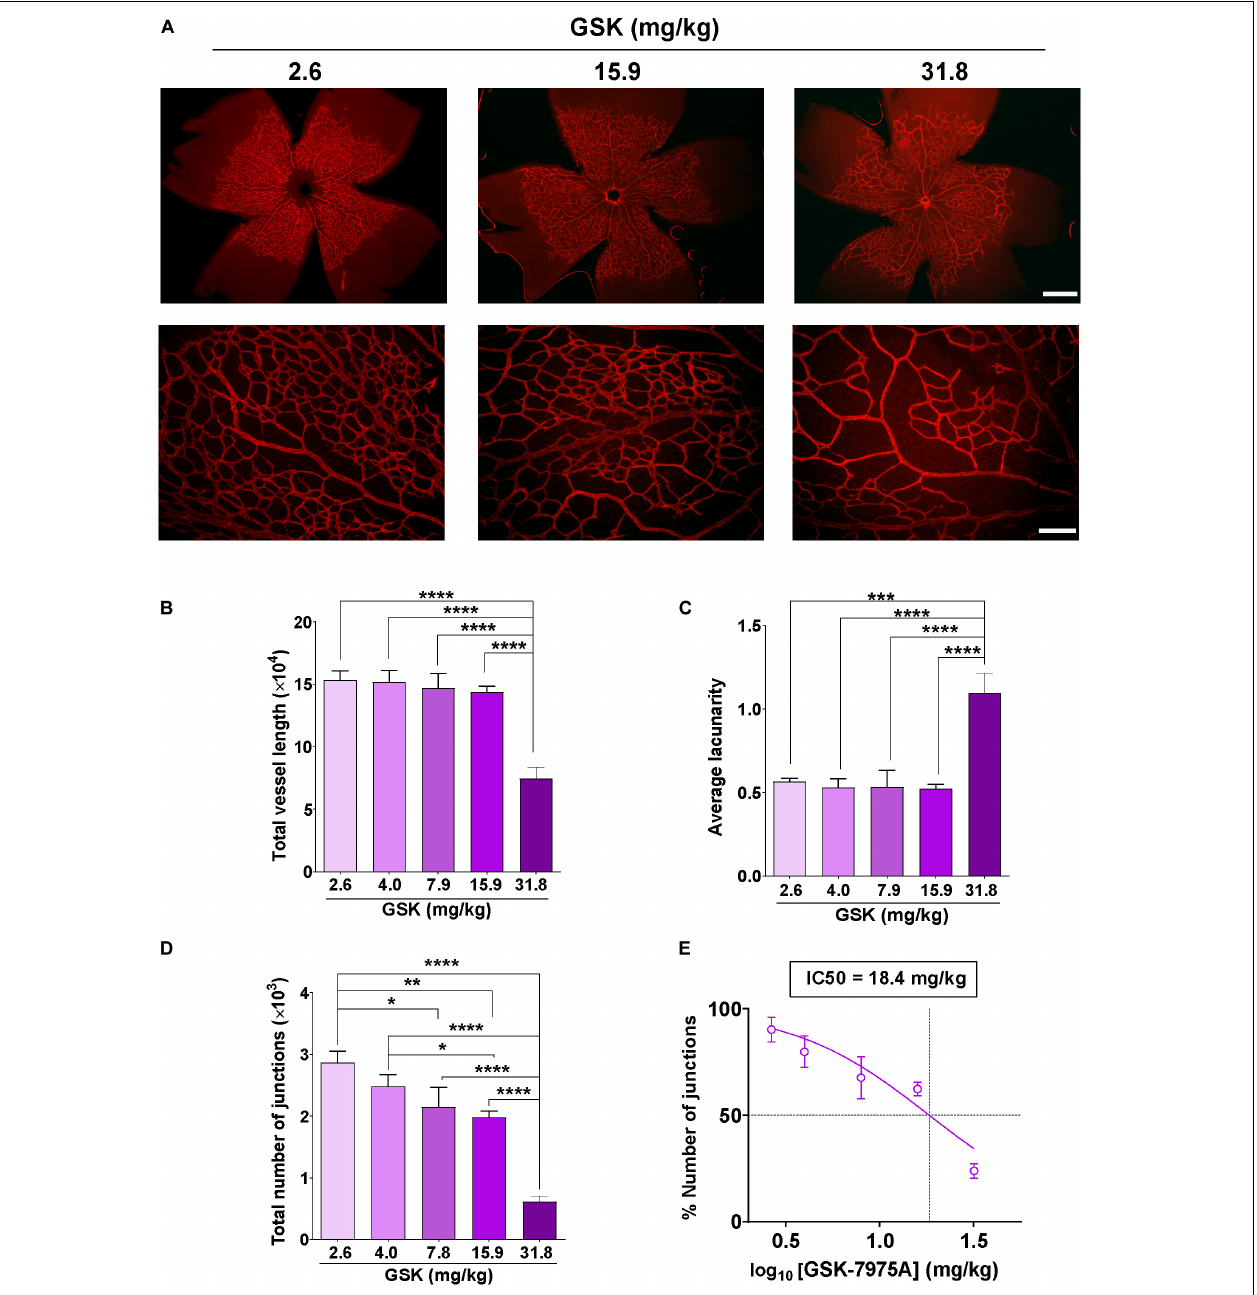
FIGURE 3 | GSK-7975A alters the vascularization of the retina. (A) Representative images of retinal blood vessels stained with Isolectin B4. Retina was isolated from P6 mouse injected with 2.6, 15.9, and 31.8 mg/kg of GSK. Fluorescence images were taken with objectives × 4 (top; scale bar = 500 µ m) and × 20 (bottom; scale bar = 100 µ m). (B–D) Bar graphs show summary data of total vessel length (B) , the average of lacunarity (C) , and the total number of junctions (D) of mouse retina vessels injected with 2.6, 4.0, 7.9, 15.9, and 31.8 mg/kg of GSK ( n = 4 to 8). (E) Curve shows the dose-dependent inhibition of % number of junctions affected by GSK-7975A IC50 = 18.4 mg/kg. The fit was done using the Hill equation (Hill slope: -1.185, 95% CI IC50 14.50 to 24.66, R 2 = 0.6480). Values are presented as the means ± S.E.M. (*), (**), (***), and (****) indicate significance with p < 0.05, p < 0.01, p < 0.001, and p < 0.0001, respectively.